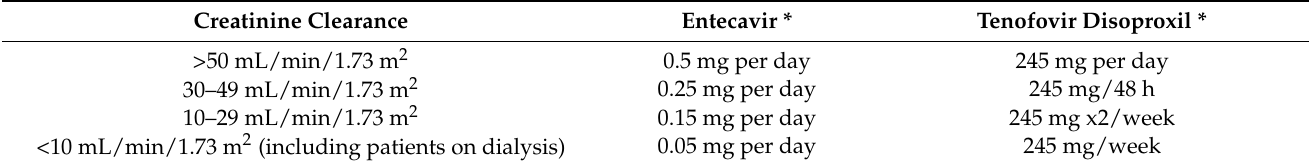
Table 3. Baraclude and tenofovir for treatment of HBV-associated liver disease in CKD. * compensated liver disease. Creatinine Clearance Entecavir * Tenofovir Disoproxil